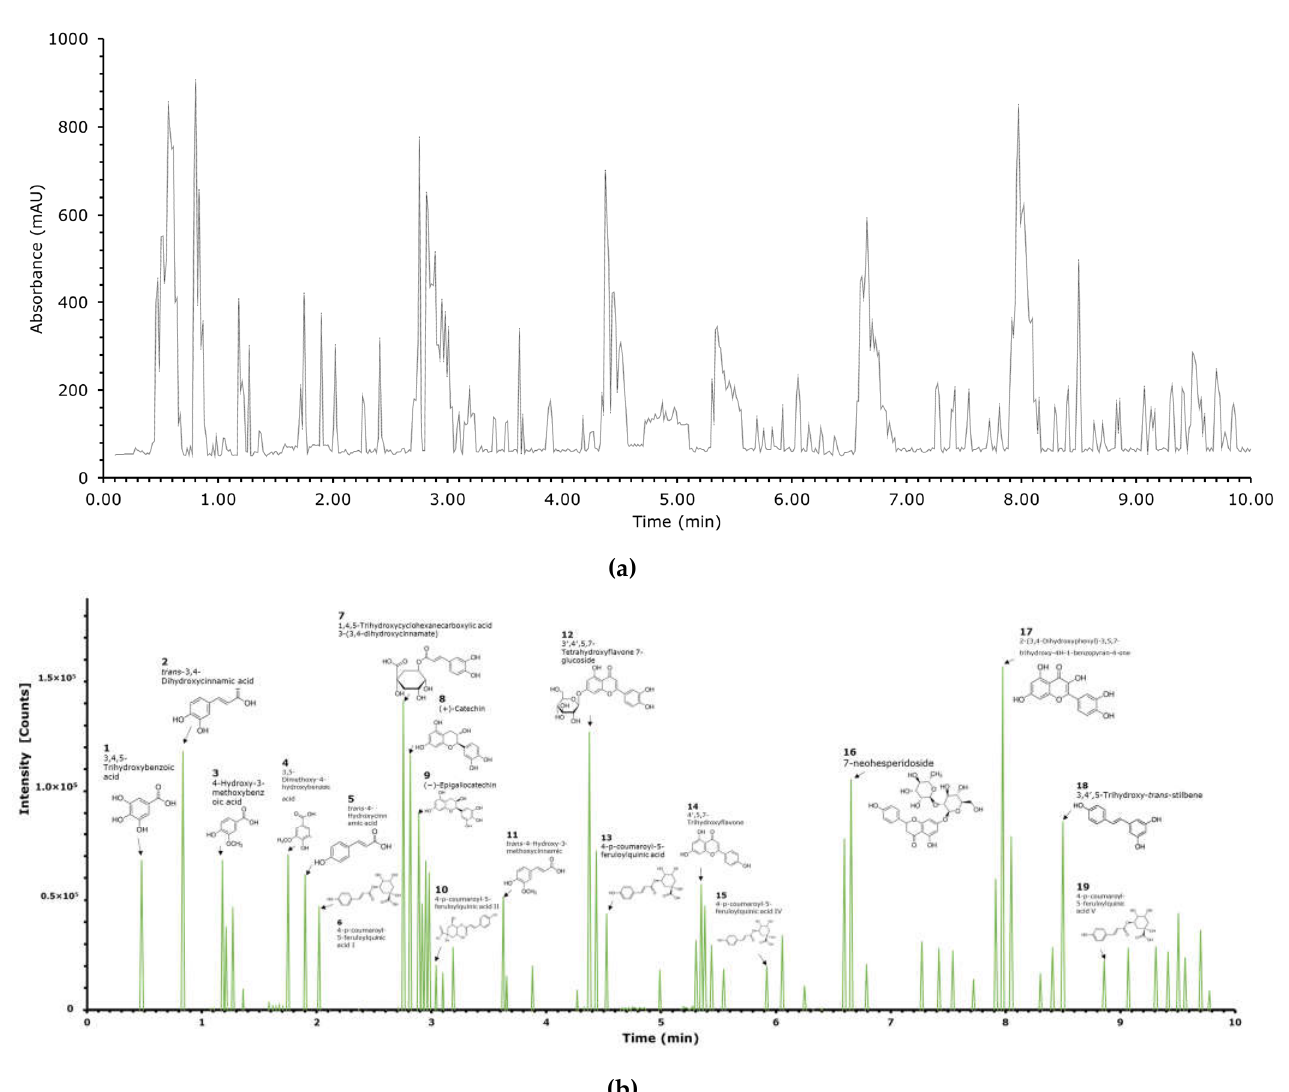
Figure 1. LC-QTOF-MS ( a ) photodiode array detector analysis spectra ( b ) MS spectra analysis of C. scolymus powder ex- tracts.